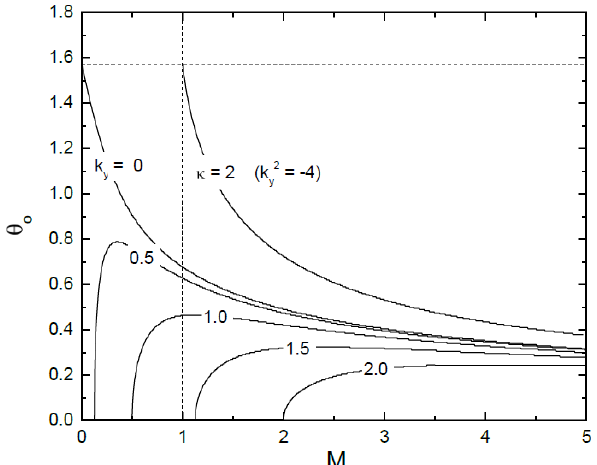
Fig. 3. The ( θ 0 ,M ) parameter space in which the region below the curves given by m = 1 is